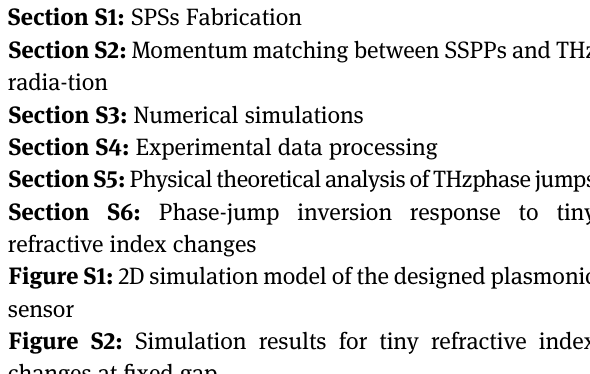
Figure S1: 2D simulation model of the designed plasmonic sensor Figure S2: Simulation results for tiny refractive index changes at fi xed